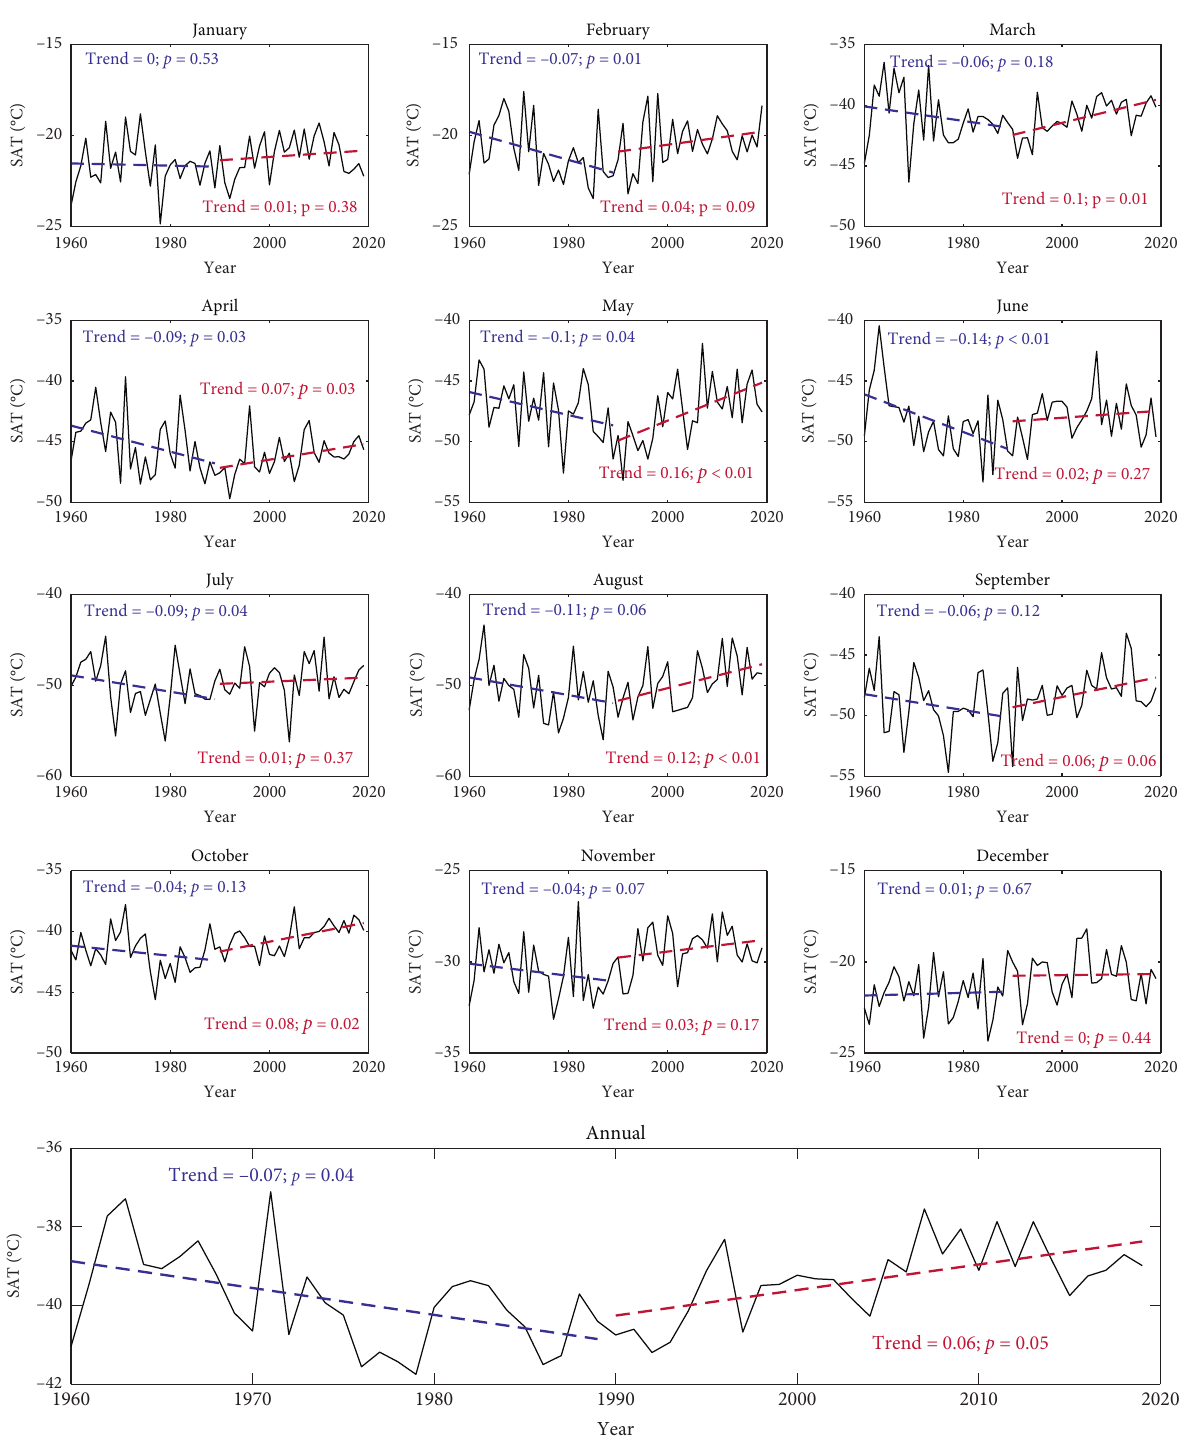
Figure 6: Temporal variations of the Antarctic SAT during 1960–2019 on monthly and annual timescales. The dotted blue and red lines denote the linear trends of the Antarctic SATduring 1960–1989 and 1990–2019, respectively. The trends (unit: ° C/year) and their significance (i.e., p values) were calculated using the Mann–Kendall trend test method